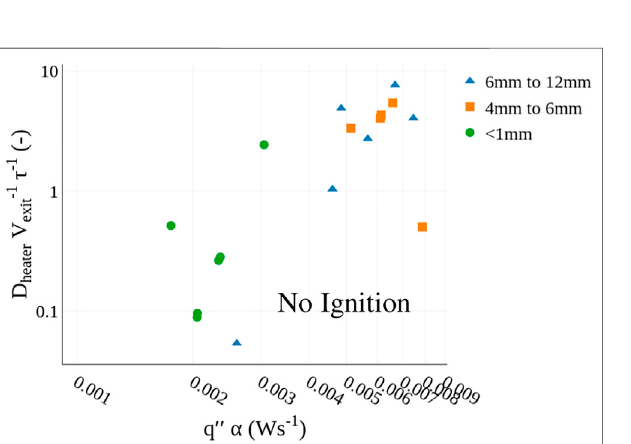
FIGURE 8 | Calculated region of fuel bed above the pyrolysis temperature 10 s after heater contact for a fi xed 750 ° C boundary (I), ignition event heat fl ux (II), and non-ignition test event fl ux (III) for L c < 1 mm (A) , 4 mm < L c < 6 mm (B) , and 6 mm < L c < 12 mm particles (C) .